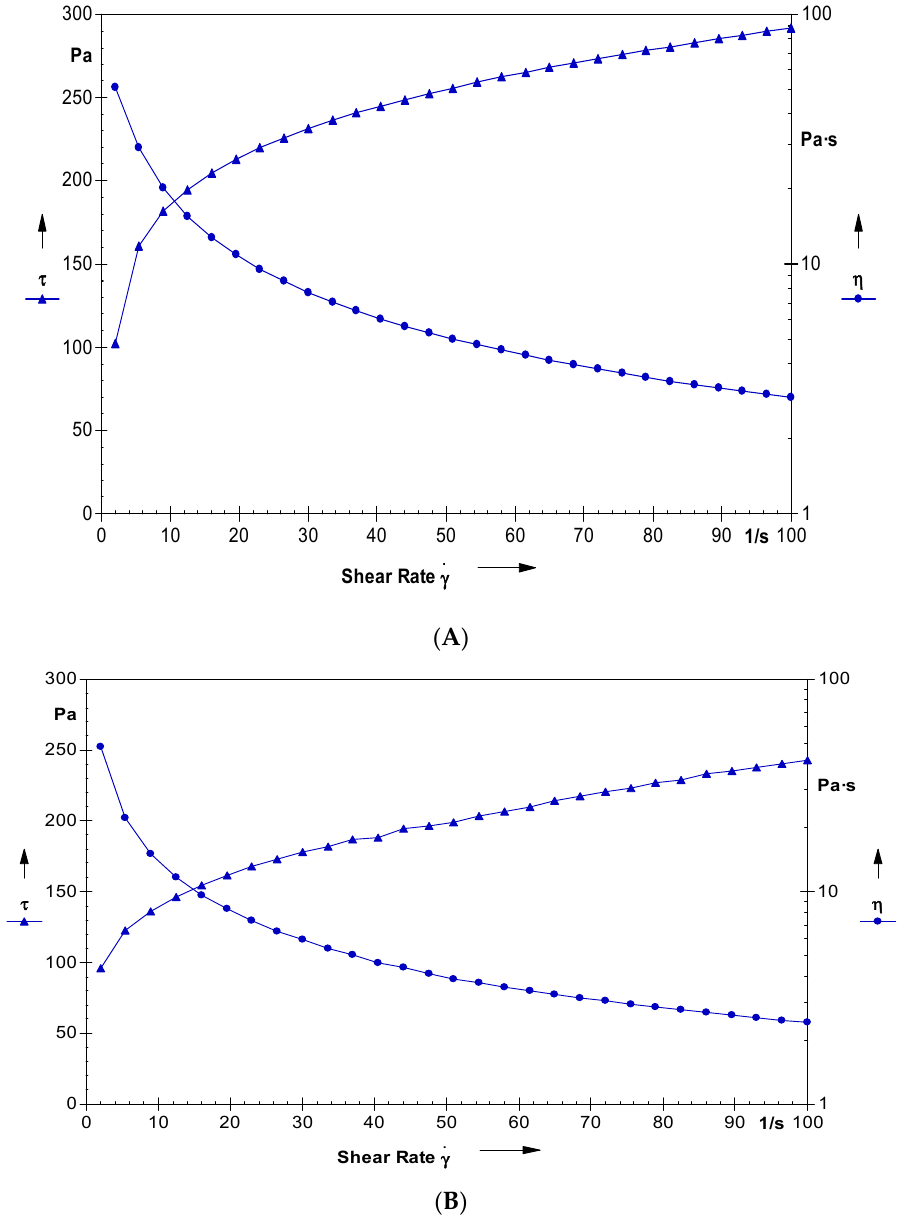
Figure 7. ( A ): The graph showing the variation in viscosity and shear stress with the varying values of shear rate for the developed nano-hydrogel. ( B ): The graph showing the variation in viscosity and shear stress with the varying values of shear rate for the developed conventional gel.